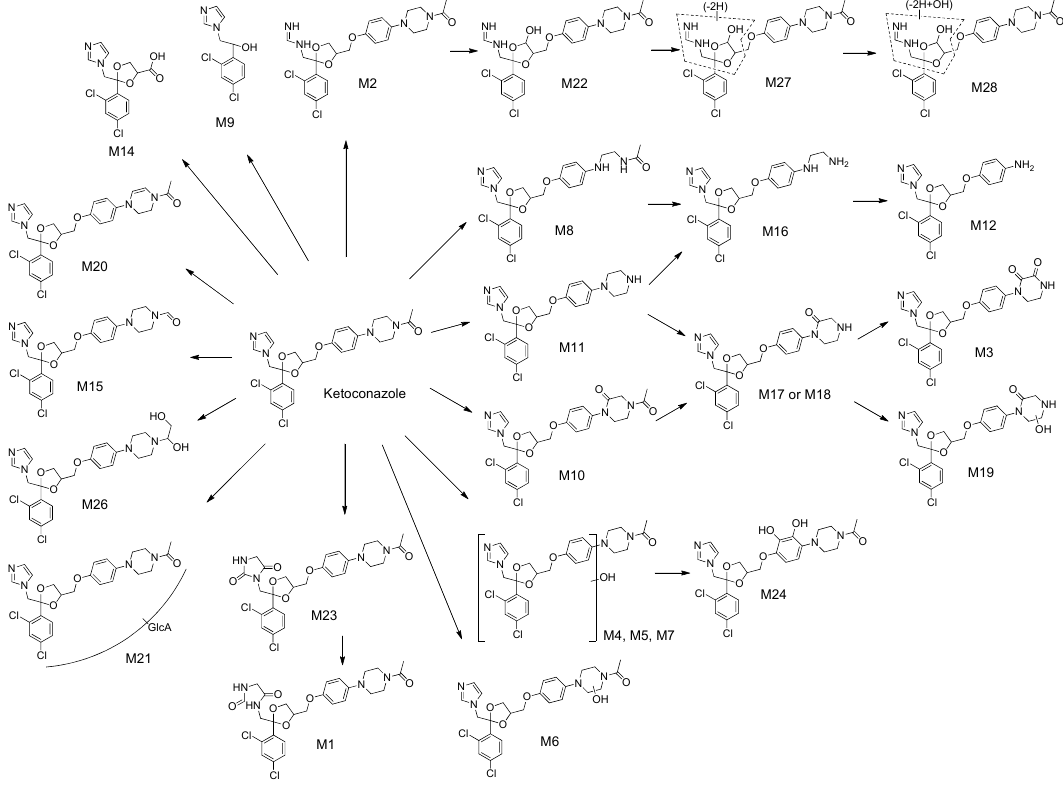
Figure 8. Proposed metabolic pathways of ketoconazole.